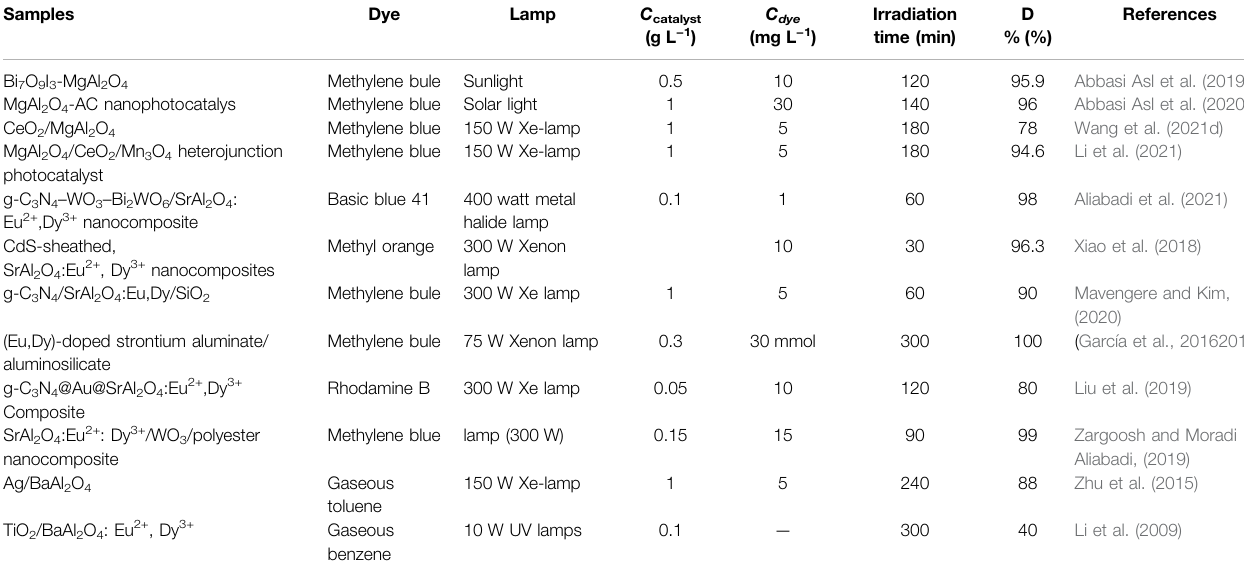
TABLE 4 | The photocatalytic activity of MAl 2 O 4 (M = Mg, Sr, and Ba) based multivariate heterojunction photocatalysts.